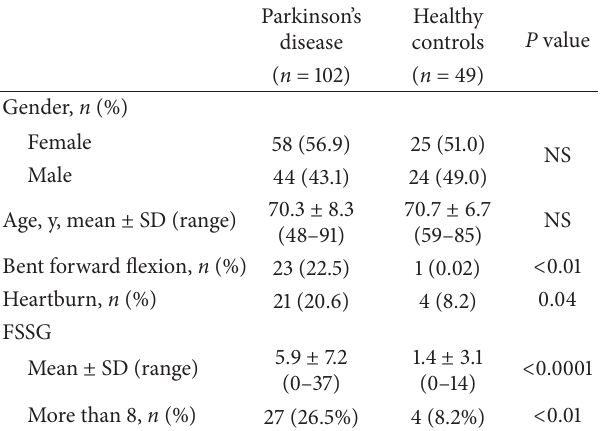
Table 2: Demographic characteristics of the participants.